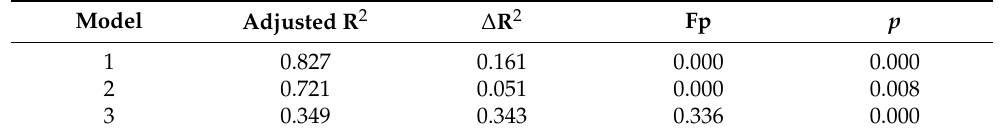
Table 5. Comparison of model testing result.